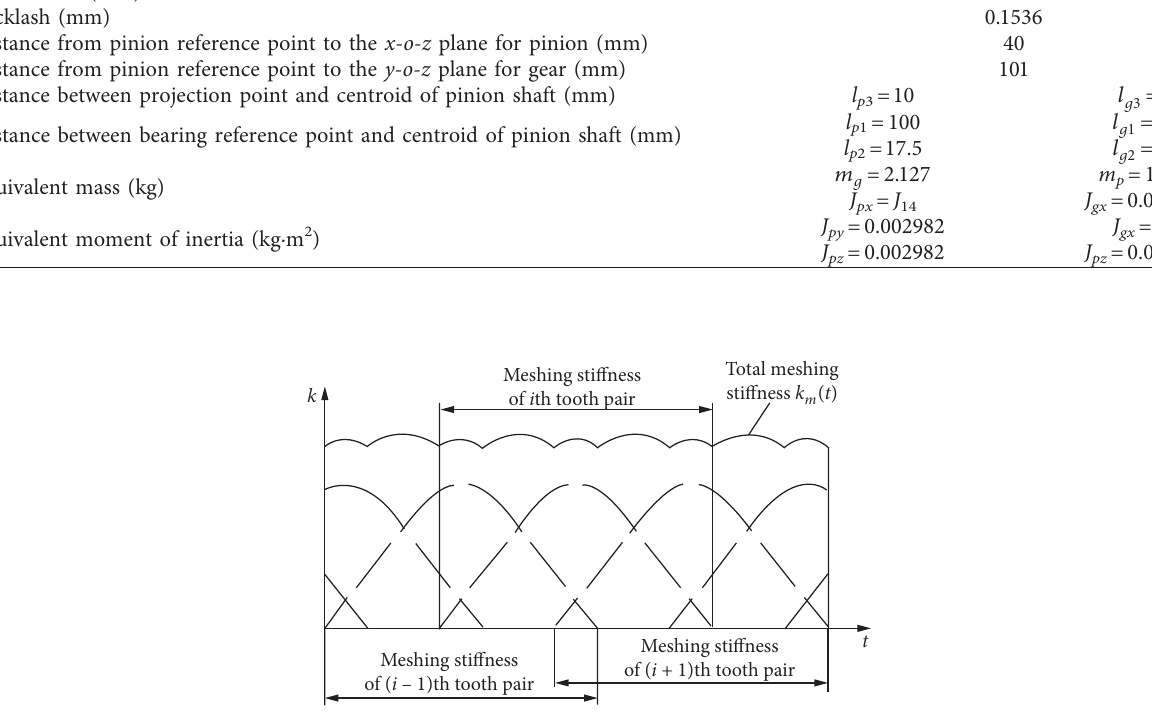
Figure 5: Schematic diagram of time-varying meshing stiffness on hypoid